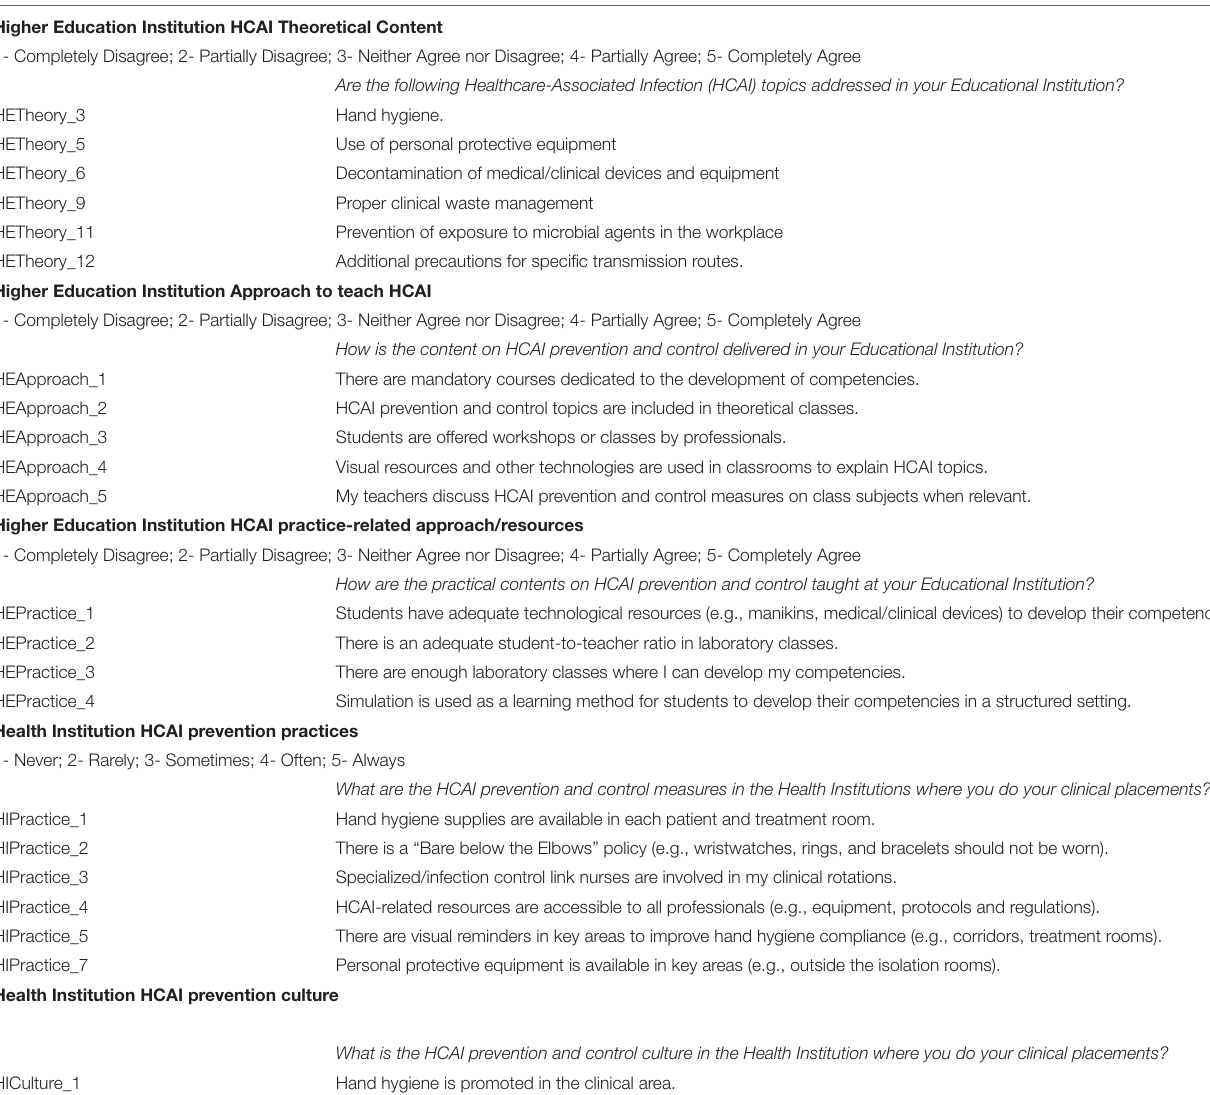
TABLE 7 | InovSafeCare Scale (81